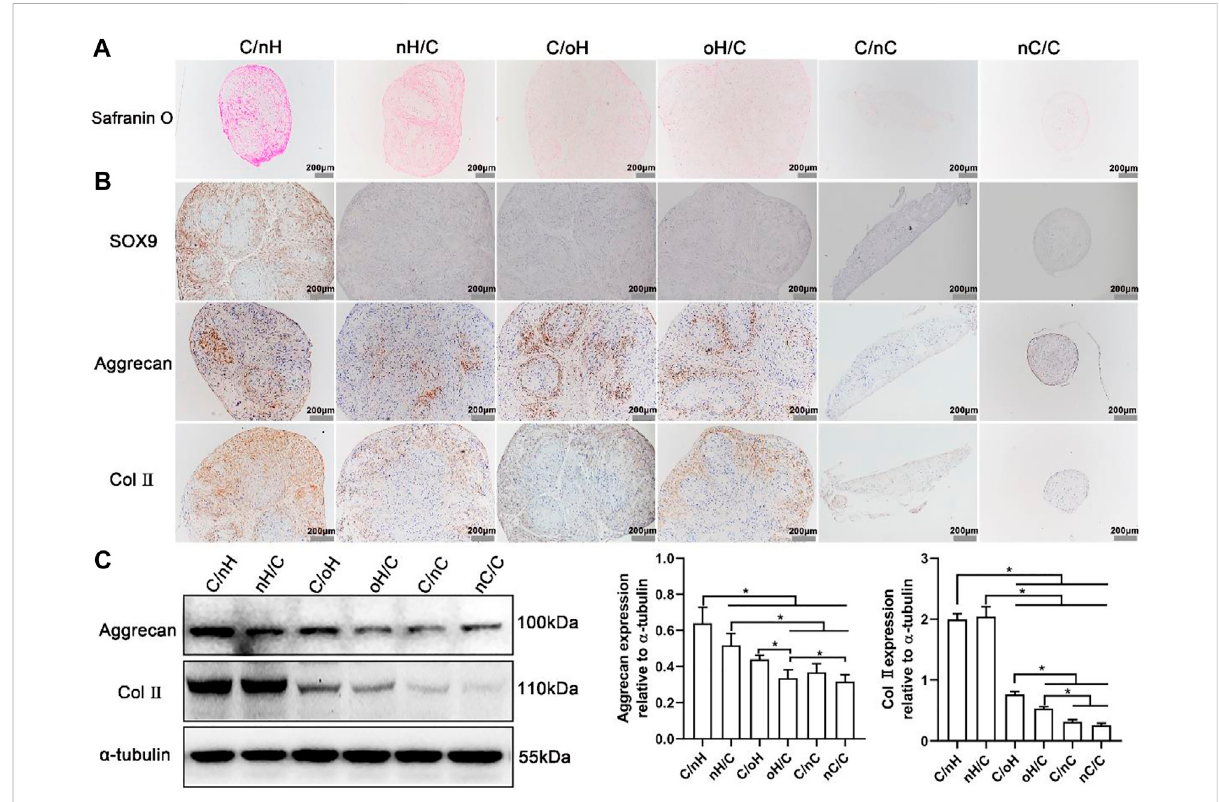
FIGURE 5 The determination of chondrogenic differentiation of hUC-MSCs placed on the different PEM (A) Safranin O staining for acidic glycosaminoglycans (GAGs) in hUC-MSCs placed on the different PEM treated with chondrogenic differentiation medium. After induction for 21 days, the cells formed microtissues were embedded in paraf fi n and sliced into sections and then stained with Safranin O; (B) Immunohistochemical staining images for Sox9, Aggrecan and Col II in cell microtissues formed on the different multilayer surfaces after 21 daysculture inchondrogenicdifferentiation medium; (C) Representative blots showingtheexpressionlevels ofchondrogenic-relatedproteinsin hUC-MSCs placed on the different multilayer surfaces after 21 days of induction in chondrogenic differentiation medium, and the associated bar plots displaying the ratios of Aggrecan and Col II to tubulin as evaluated by densitometric analysis of western blots. The multilayers are the same as described in Figure